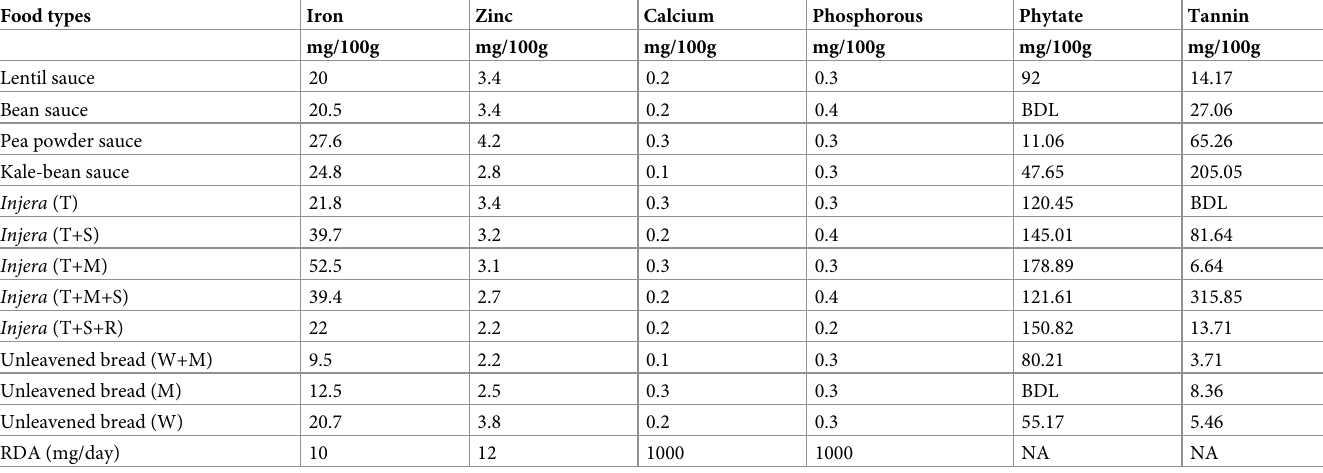
Table 7. The content of minerals and anti-nutritional factors (dry weight basis) of sampled maternal foods in three districts of Jimma Zone, Southwest Ethiopia. Food types